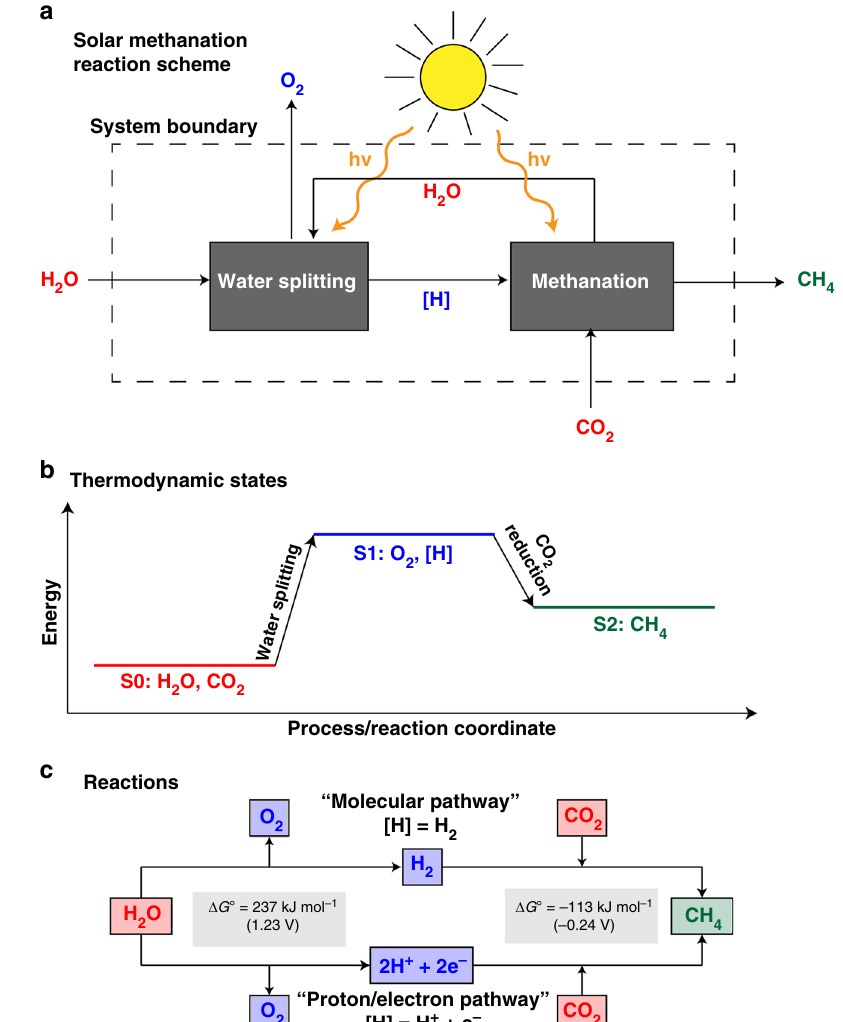
Fig. 2 Graphical representation of solar methanation reaction schemes and energetics. a In a fi rst reaction step, water is split into reducing equivalents [H] and O 2 . [H] can be molecular H 2 or a H + /e − pair. If [H] is molecular H 2 , then CO 2 is reduced to CH 4 via the “ molecular pathway ” . If [H] is a H + /e − pair, then CO 2 is reduced to CH 4 via the “ proton/electron pathway ” . b Graphical representation of the thermodynamic states of the solar methanation reaction. The energy level of the system is elevated from S0 to S1 during the water splitting step. Energy is released during CO 2 reduction, reaching the energy level of the products, S2. c Reactions occurring during the solar methanation pathways shown in a . The “ molecular ” pathway represents the state-of-the-art of industrial methanation, where H 2 is produced during water electrolysis, as discussed in the “ State-of-the-art industrial CO 2 methanation ”